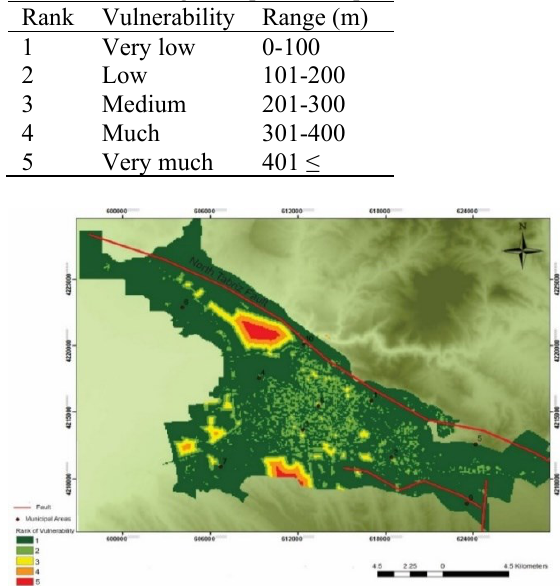
Fig. 11. Vulnerability map of Tabriz city based on distance from parks and green